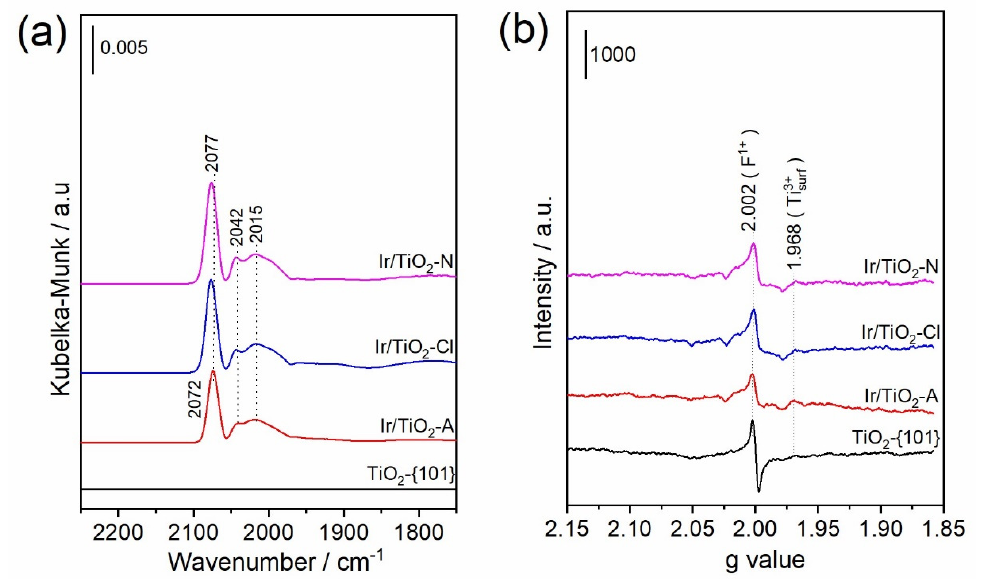
Figure 5. ( a ) in situ DRIFTS of CO adsorption at 30 °C and ( b ) EPR spectra at 130 K of the pre-reduced bare TiO 2 -{101} NCs and Ir/TiO 2 catalysts. (Note: the EPR intensity comparisons of different samples were carried out based on the same load- ing (ca. 30 ± 1